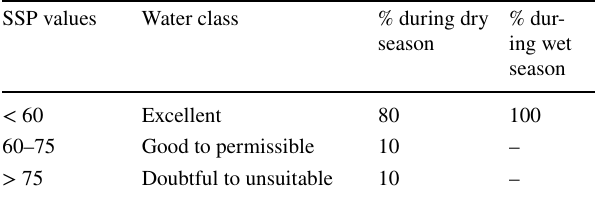
Table 11 Quality of groundwater based on SSP